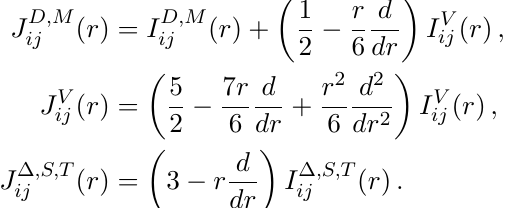
A second set of dimensionless integrals J N the derivative operations